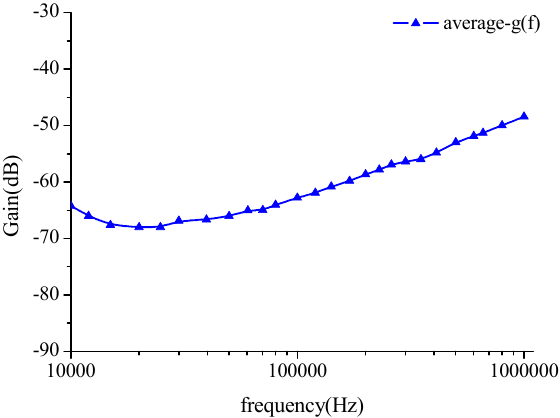
Figure 8. Mean values of the estimation results for long distance intra-body communication channel characteristics in the field-circuit model.